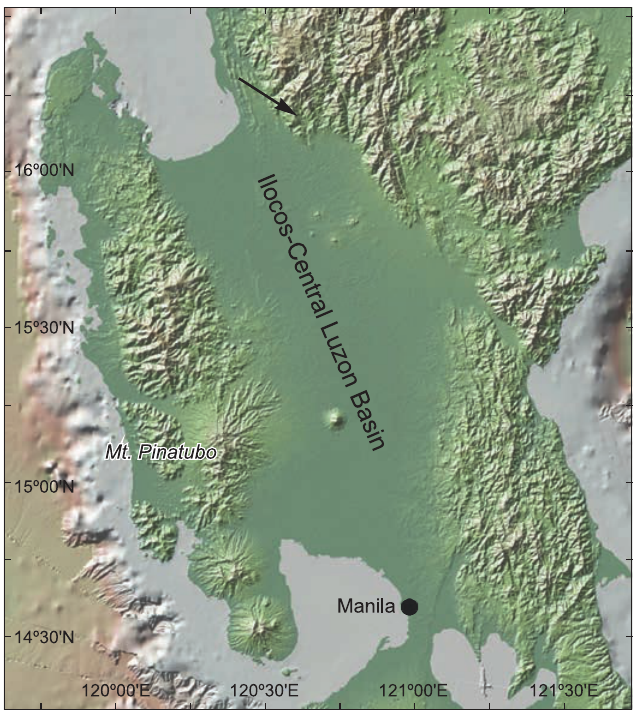
Fig. 1. Map showing the location of the Northern Cement Corporation (NCC) quarry in the province of Pangasinan, Luzon, Philippines (arrow). Modified from www.geomapapp.org (CC-BY) and Ryan et al.